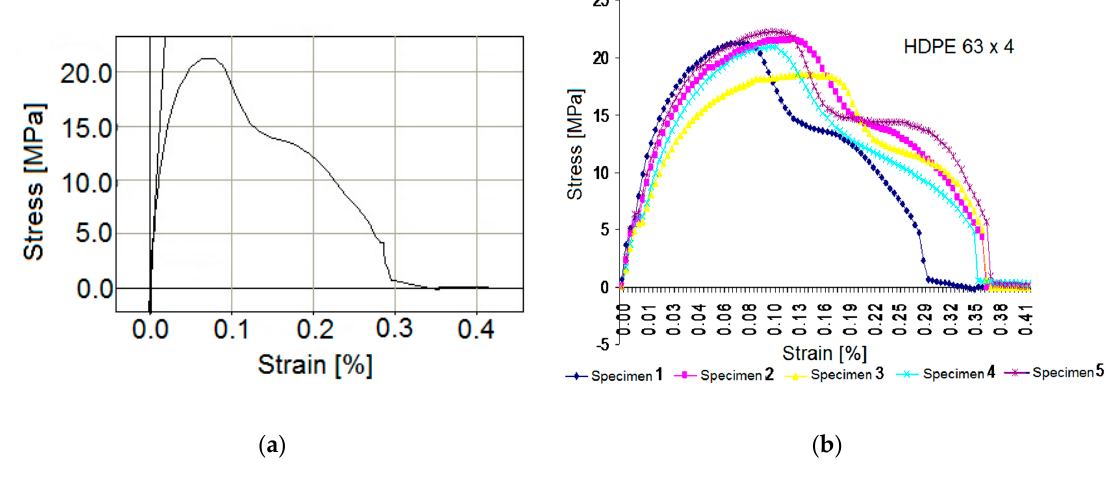
Figure 4. Diagram stress-strain for traction test, pipe Ф 63 × 4.